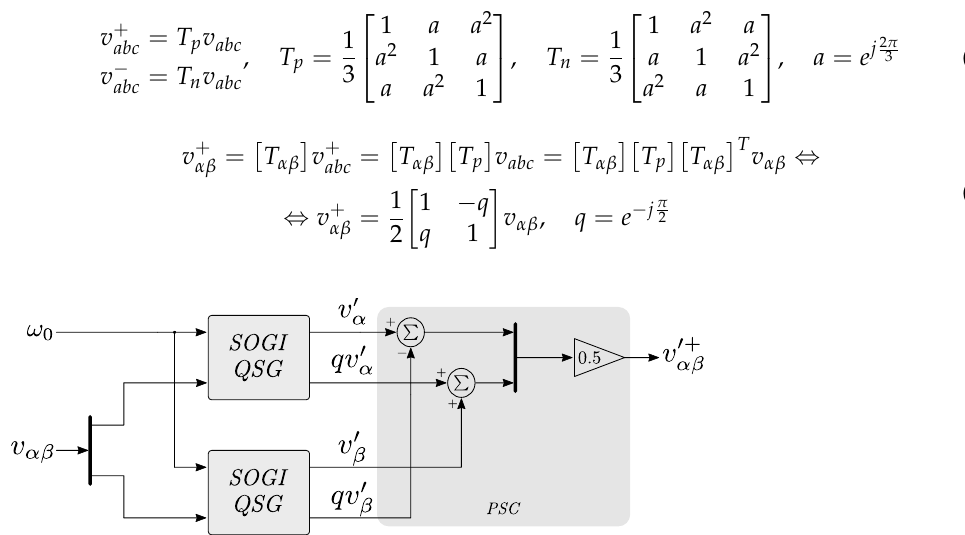
Figure 4. DSOGI-QSG block